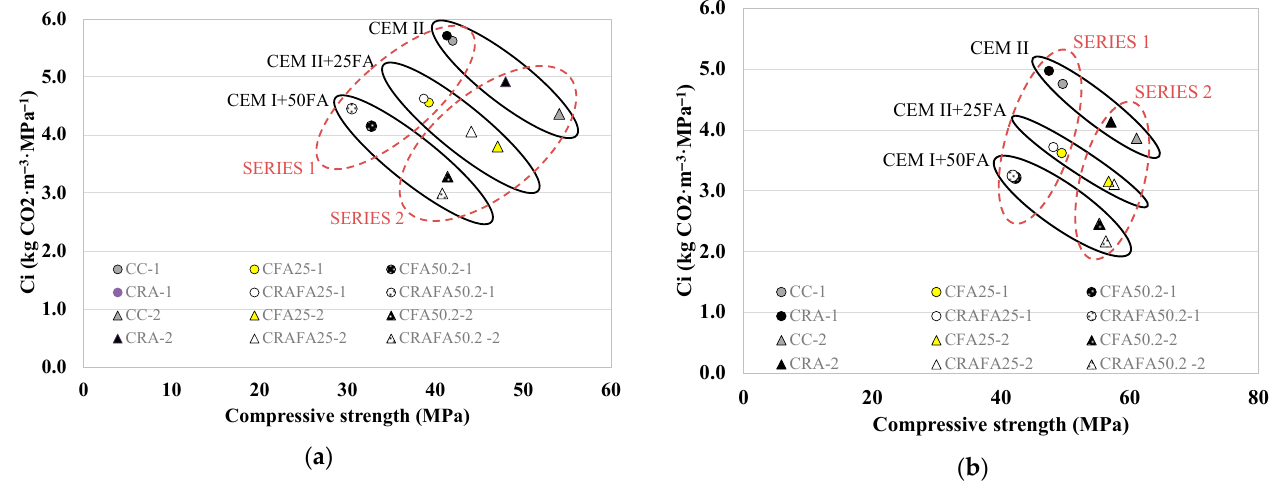
Figure 11. Ci (CO 2 intensity) versus compressive strength for the concretes at ( a ) 28 days and ( b ) 90 days.